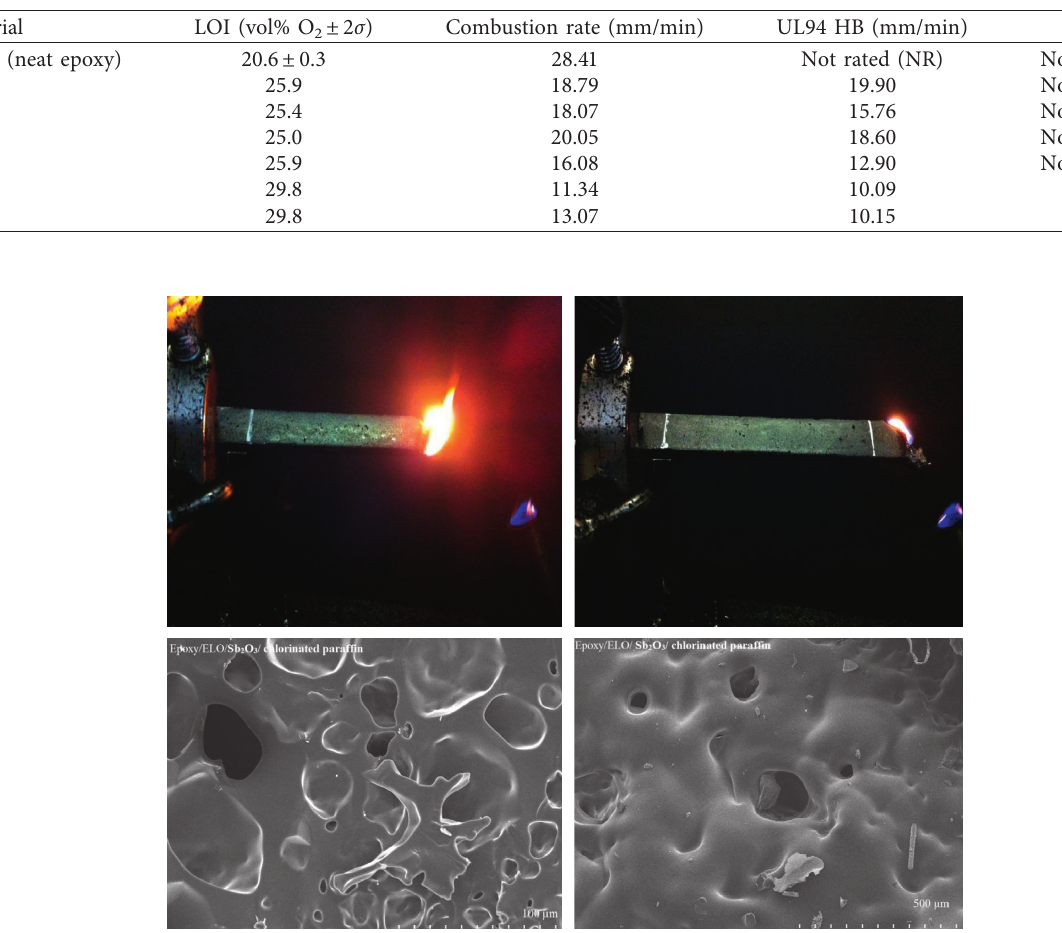
2 O 3 /chlorinated paraffin from ignition by an